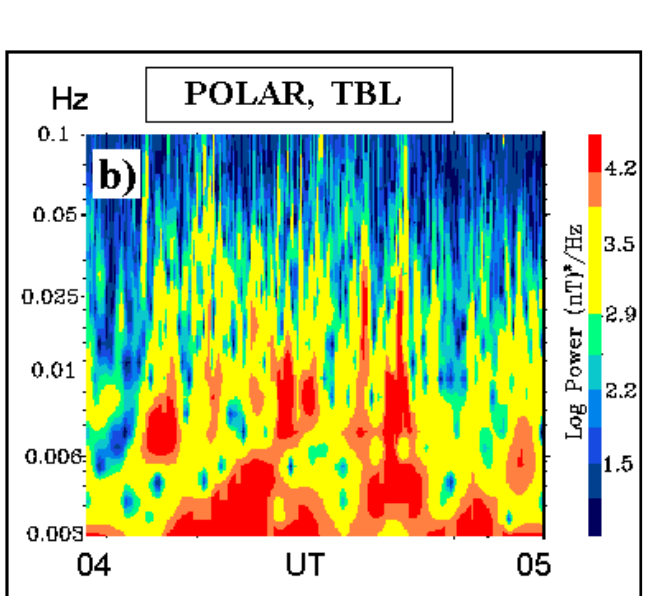
Fig. 5a. Interball-1 wavelet spectro- gram in the MSH ( B y GSM component, 0.003–0.1Hz) at 04:00–05:00UT (see also Plate A1);